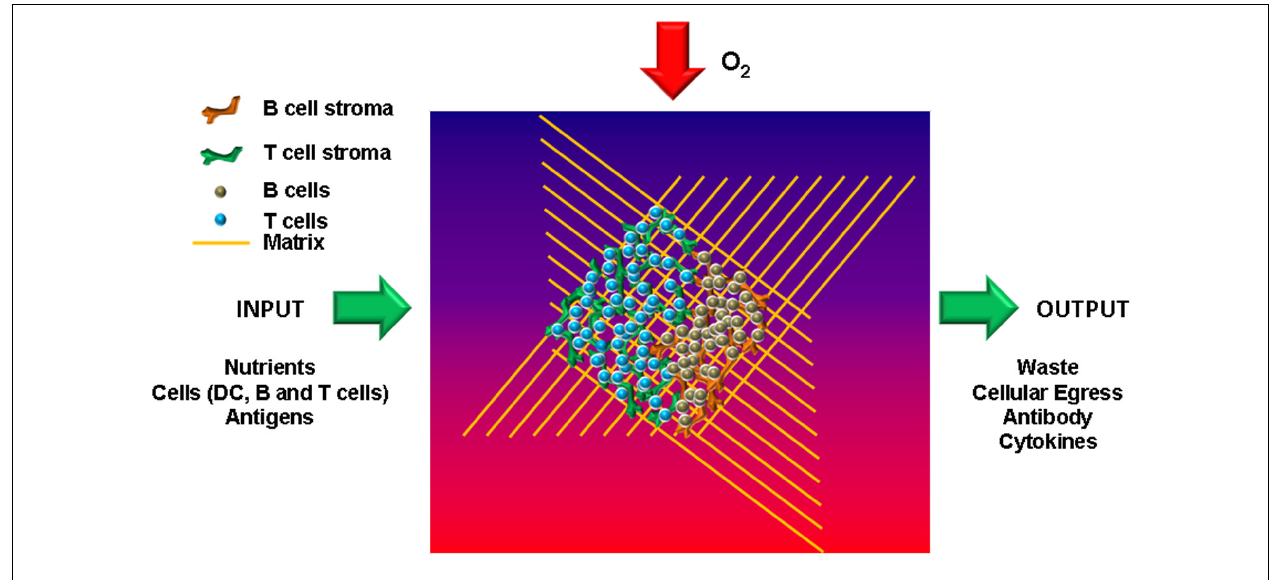
FIGURE 1 | Key features of an artificial lymph node. To recreate functional lymph nodes in vitro several key constituents need to be incorporated.These include specific stromal cells forT and B areas in order to generate the typical